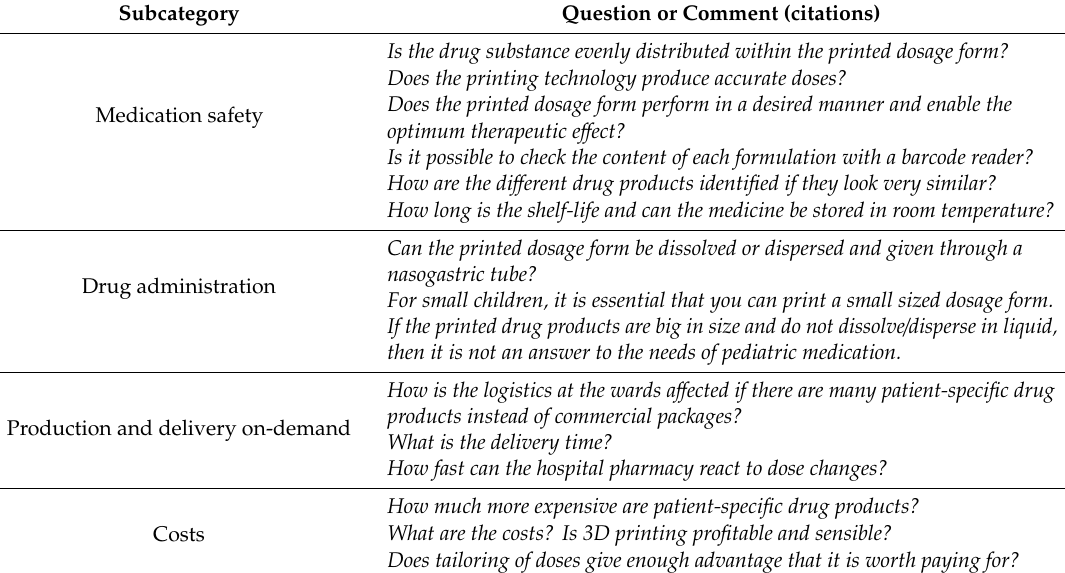
Table 3. Concerns about 3D-printed drug products expressed by the healthcare professionals attending the focus group